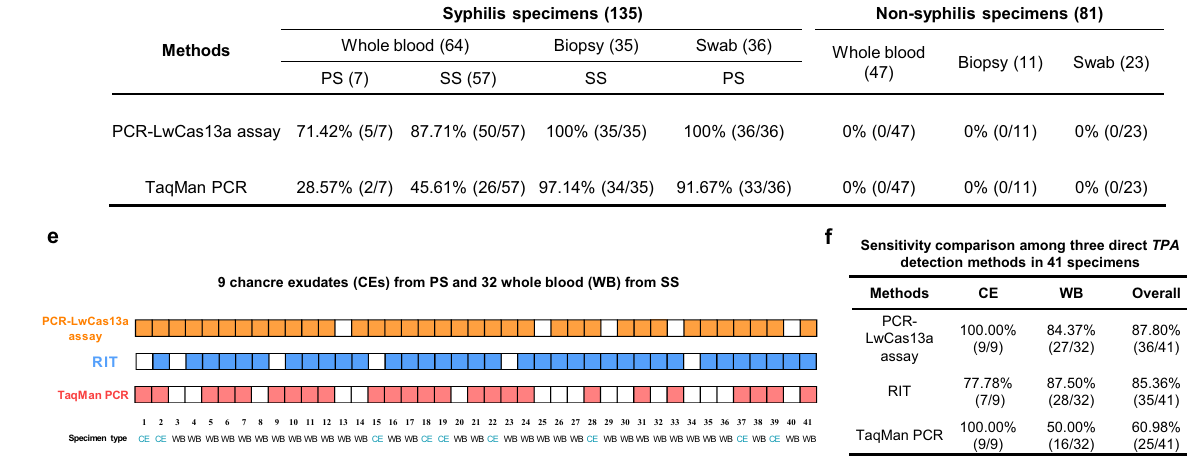
with secondary syphilis and chancre exudates from nine patients with primary syphilis. Squares with color (orange for PCR-LwCas13a assay, blue for rabbit- infectivity test, and red for TaqMan PCR) represent positive signals, while white squares represent negative results. Dark fi eld microscopy of testicular extracts was used to determine RIT results. f Comparison ofthe sensitivities of direct detection methods. Abbreviations: A.U. Arbitrary units, PS Primary syphilis, SS Secondary syphilis, CE Chancre exudate, WB Whole blood, RIT rabbit-infectivity test. n =3 technical replicates; two-tailed Student t -test was used to analyze the statistical signi fi cance; p -value was labeled in the fi gure, ns=not signi fi cant; error bars represent mean±SEM. Source data are provided as a Source Data fi